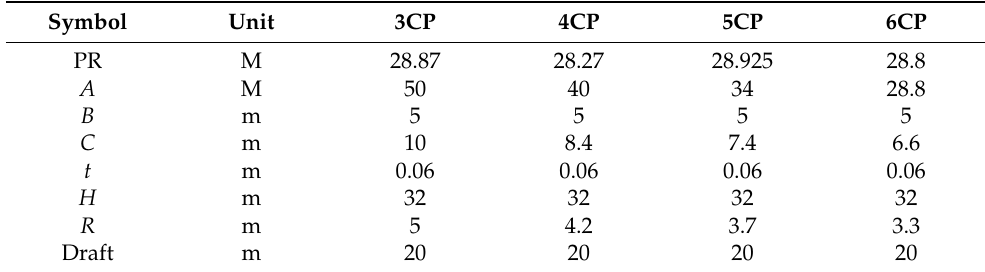
Table 4. Platform geometry